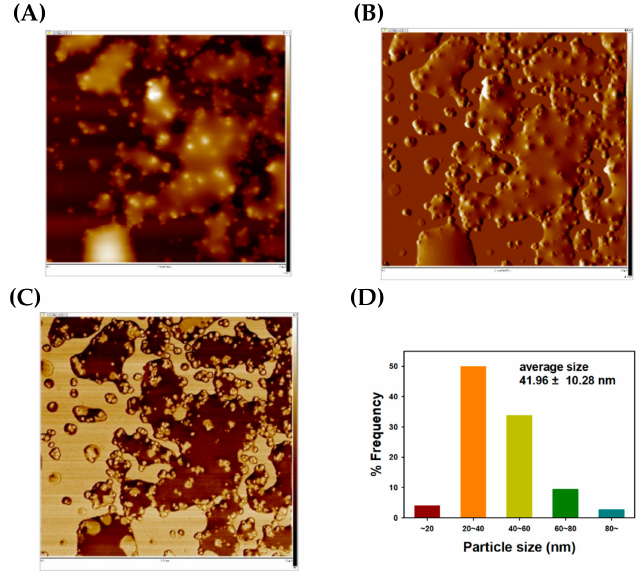
Figure 7. AFM images and a size histogram of TF-AuNPs. ( A ) height sensor image (2.5 µ m × 2.5 µ m), ( B )amplitudeerrorimage(2.5 µ m × 2.5 µ m), ( C )phaseimage(2.5 µ m × 2.5 µ m), and( D